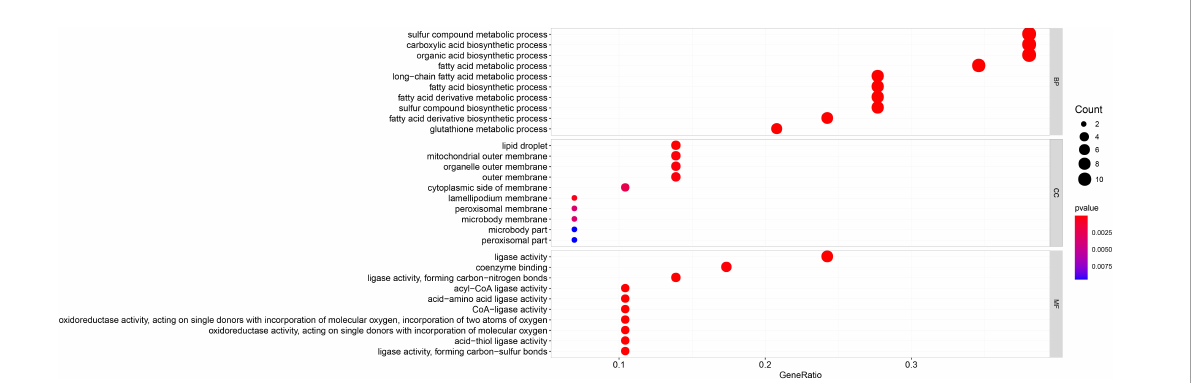
FIGURE3 Gene Ontology enrichment of 29 differential FRGs. The count shows the number of genes enriched in the pathway. Gene ratio: the ratio of the FRGs number in this term to the total number of FRGs.